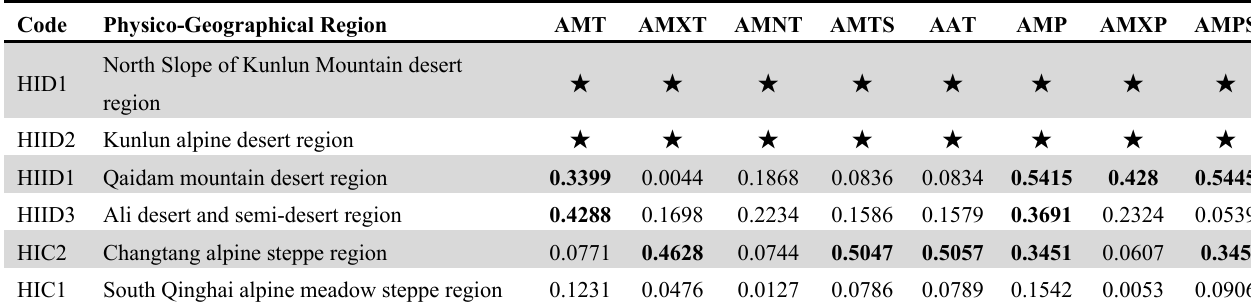
3. Correlation coefficients of MNDVI with climatic factors at the physico-geographical regions of the Tibetan